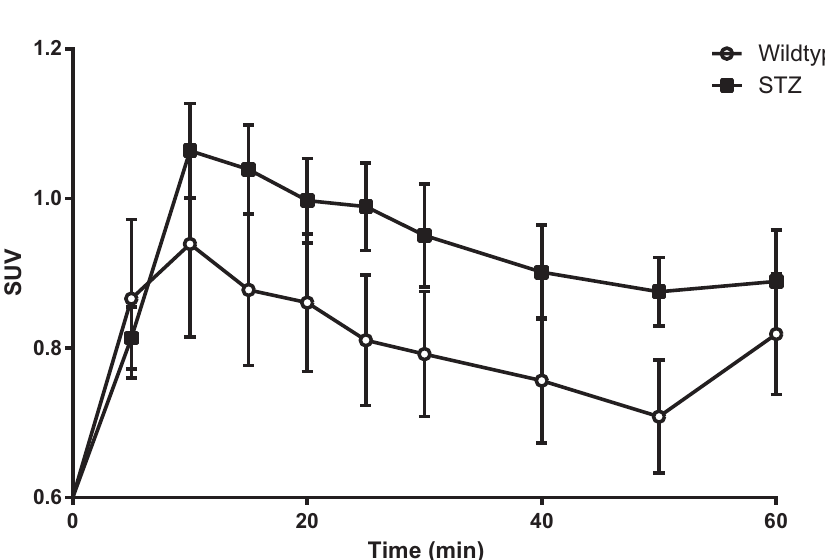
Figure 5. Time-activity curves for 18 F-L-FEHTP uptake in the pancreas of wt and STZ-treated mice. TACs are expressed as SUVs from regions corresponding to regions of interest from six image slices corresponding to the pancreas. Values are means ± SEM (n=4). There were no significant differences at any of the time points.